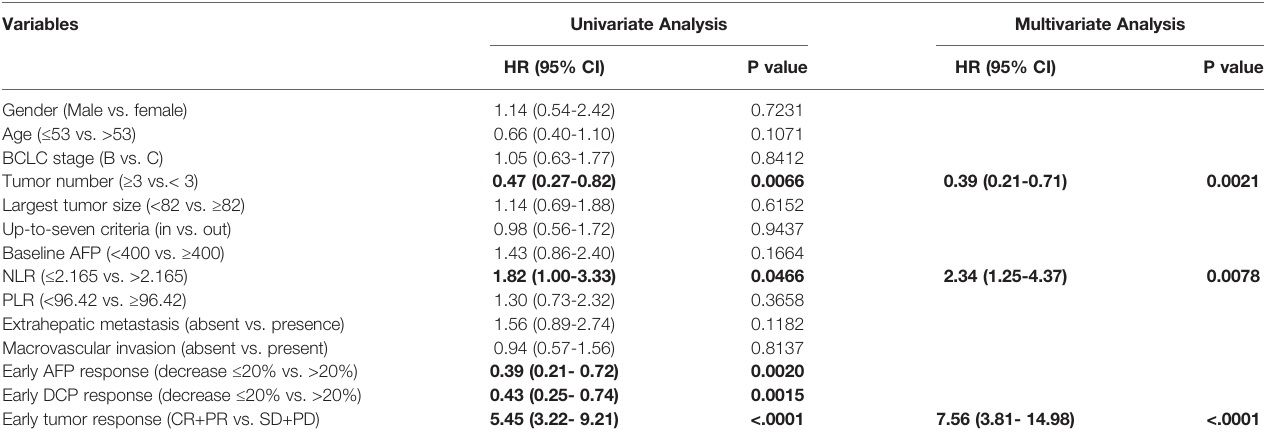
TABLE 5 | Multivariable Cox regression analysis for progression-free survival.